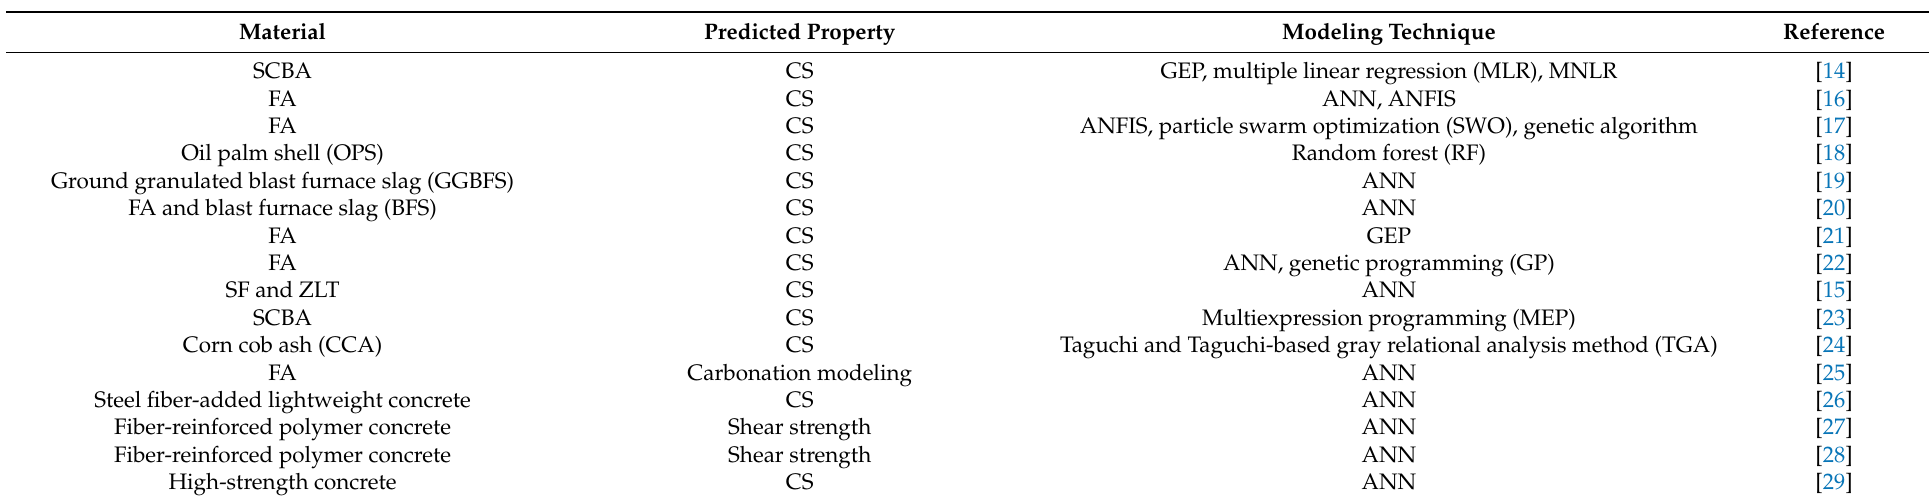
Table 1. Some recent studies using